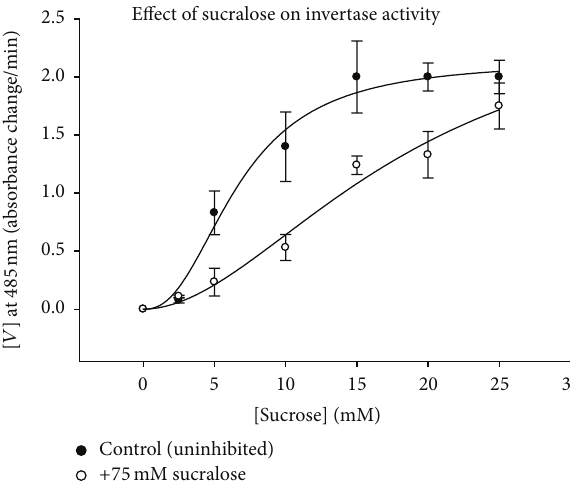
hibited invertase reaction and invertase inhibited with sucralose. The overlapping 𝑉 max values but different 𝐾 𝑚 values for the reactions indicate competitive inhibition. The error bars are means ± 1SEM ( 𝑛 = 5